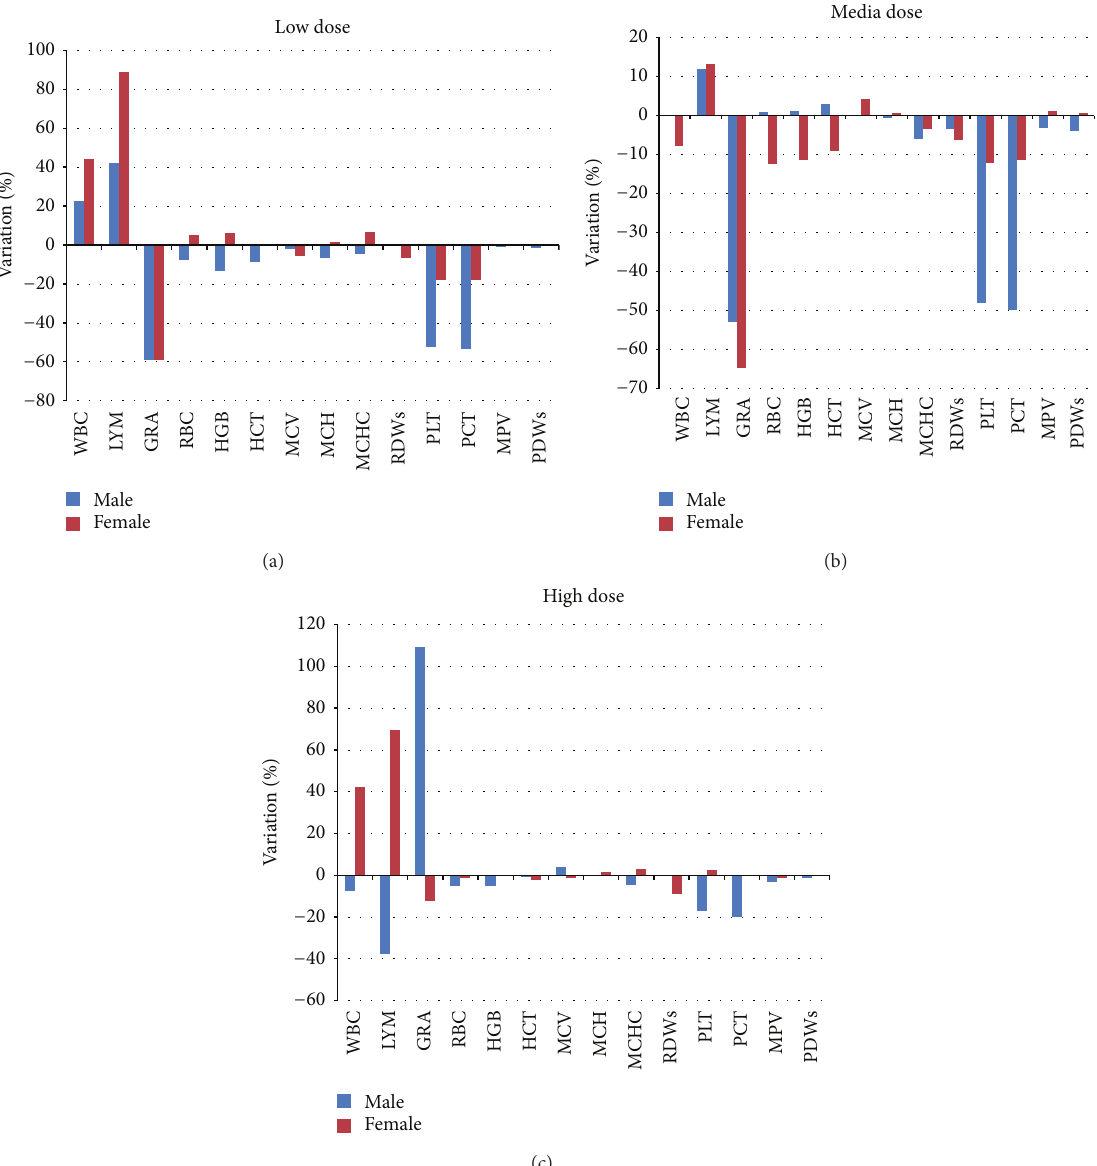
Figure 12: (a): Percentages of variation after subacute treatments compared to the negative control. WBC: white blood cells; LYM: lymphocyte test;GRA:granulocyte;RBC:redbloodcells;HGB:hemoglobin;HCT:hematocrit;MCV:meancorpuscularvolume;MCH:meancorpuscular hemoglobin; MCHC: mean corpuscular hemoglobin concentration; RDWs: red cell distribution width; PLT: platelet; PCT: plateletcrit; MPV: mean platelet volume; and PDWs: platelet distribution width. (b) Percentage of variation of parameters compared to the negative control results. WBC: white blood cells; LYM: lymphocyte test; GRA: granulocyte; RBC: red blood cells; HGB: hemoglobin; HCT: hematocrit; MCV: mean corpuscular volume; MCH: mean corpuscular hemoglobin; MCHC: mean corpuscular hemoglobin concentration; RDWs: red cell distribution width; PLT: platelet; PCT: plateletcrit; MPV: mean platelet volume; PDWs: platelet distribution width. (c) Percentage of variation of parameters compared to the negative control results. WBC: white blood cells; LYM: lymphocyte test; GRA: granulocyte; RBC: red blood cells; HGB: hemoglobin; HCT: hematocrit; MCV: mean corpuscular volume; MCH: mean corpuscular hemoglobin; MCHC: mean corpuscular hemoglobin concentration; RDWs: red cell distribution width; PLT: platelet; PCT: plateletcrit; MPV: mean platelet volume; and PDWs: platelet distribution